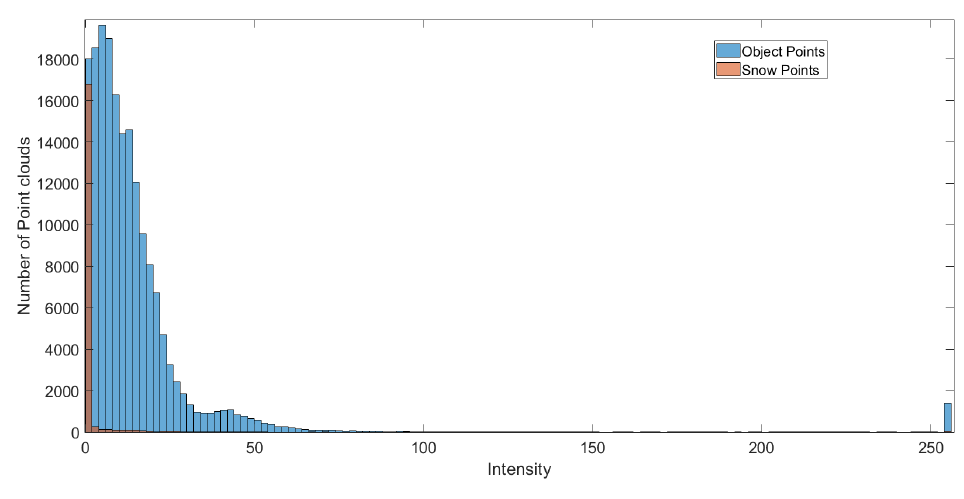
Figure 2. Point clouds distribution from the WADS. ( a ) The simulation of a raw point clouds data with intensity as color. Snow points appear in black circles. Snow spots are very low intensity and appear densely around the vehicle. ( b ) Histogram of intensity from two classes: snow points and object points in raw data. Snow spots are obtained at an intensity close to 0, while object points have a wider distribution and appear more frequently in the range from 0 to